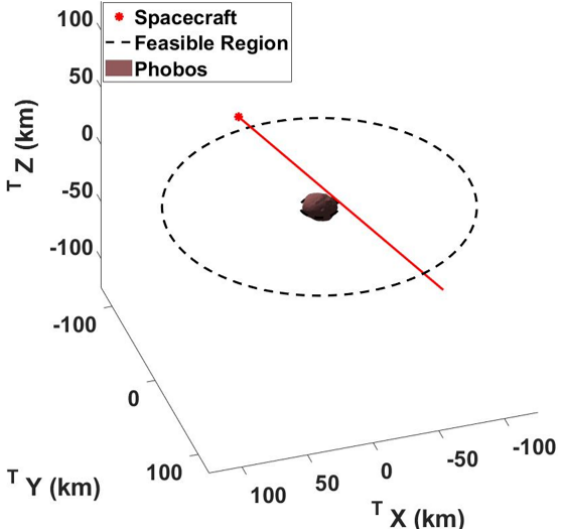
Figure 18. Visualization of spacecraft trajectory relative to Phobos during a simulated encounter.